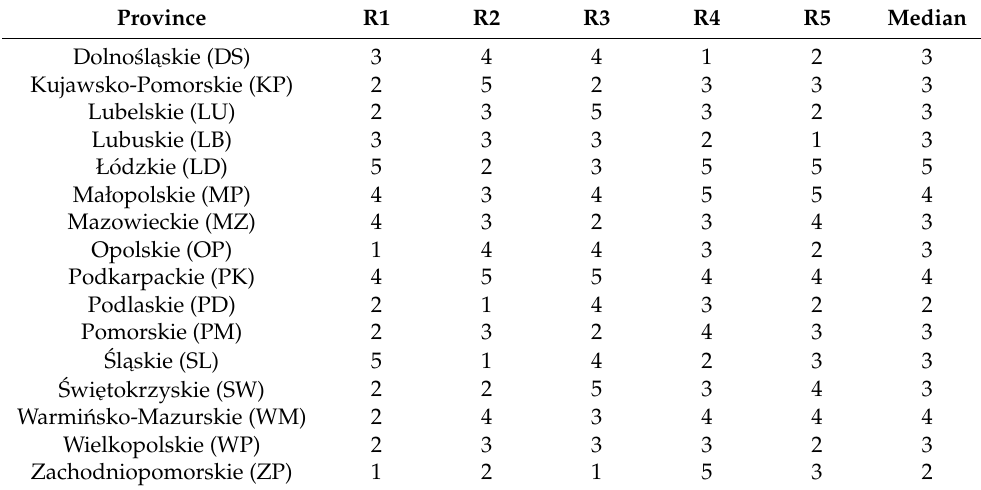
Table 4. Road transport development evaluation—classification. Source: the